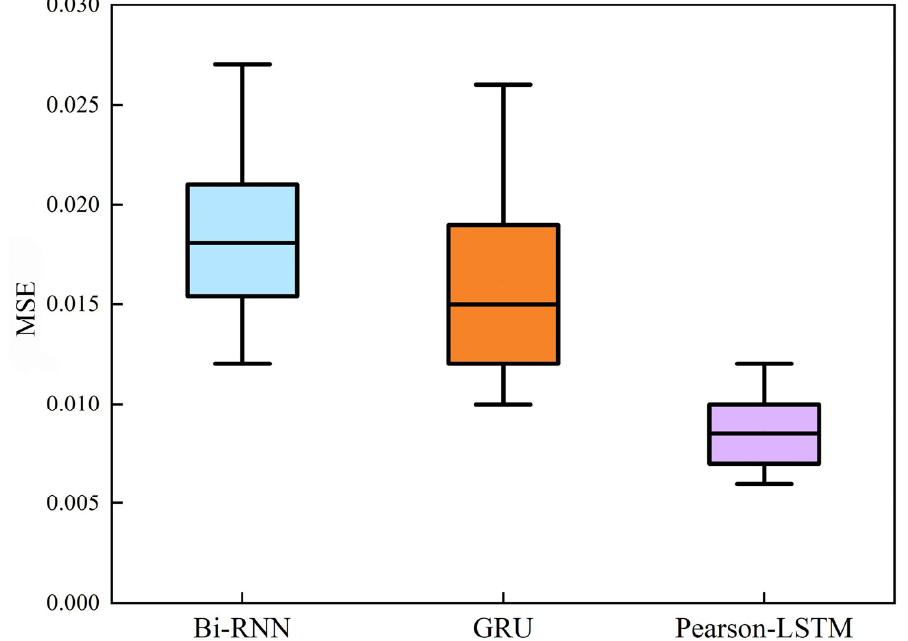
Figure 15. Box diagram of the prediction errors of the three models.